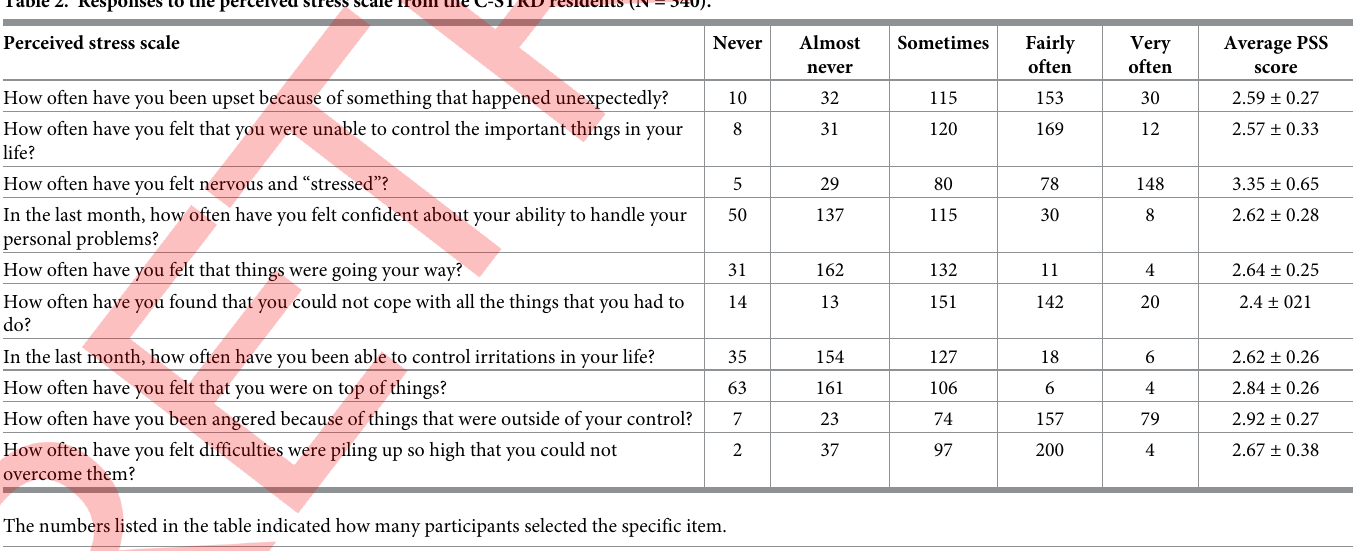
Table 2. Responses to the perceived stress scale from the C-STRD residents (N = 340). Perceived stress